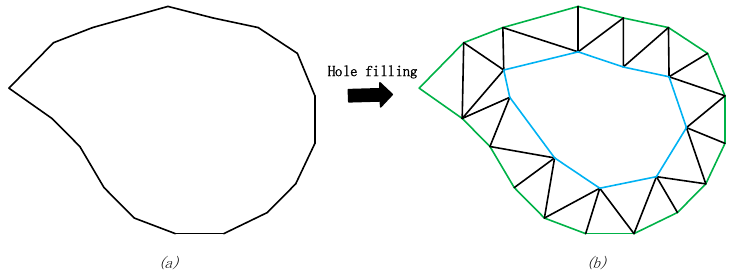
Figure 6. A layer of inserted and triangulated vertices in a hole-area. (a) A simple hole before repairing and (b) the hole after repair.